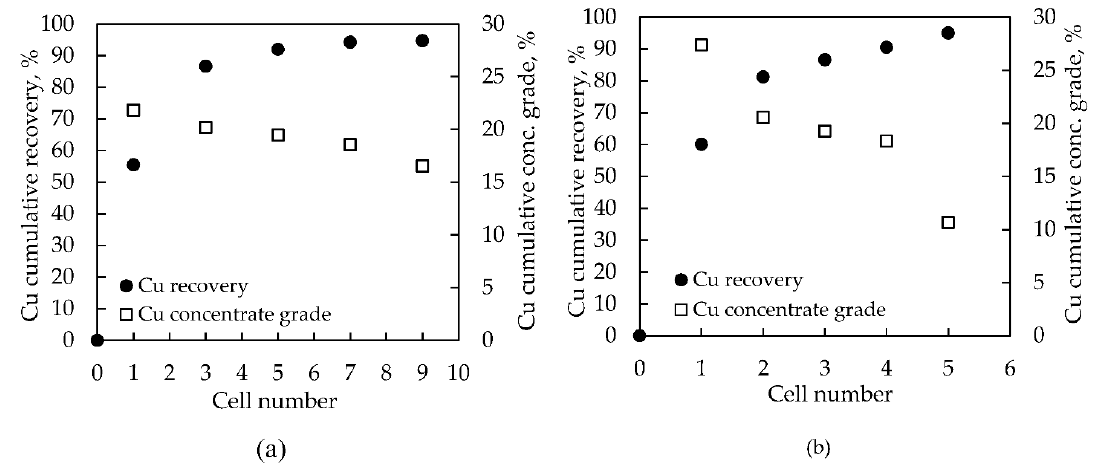
Figure 1. Cumulative recoveries and concentrate grades, circuits A ( a ) and B ( b ).